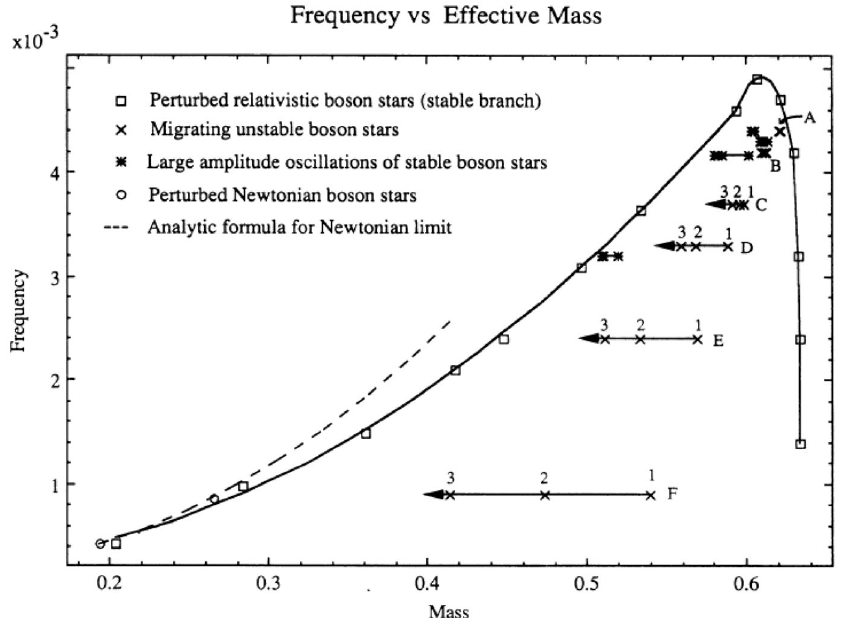
Fig. 15 Oscillation frequencies of various boson stars are plotted against their mass. Also shown are the oscillation frequencies of unstable BSs obtained from the fully nonlinear evolution of the dynamical system. Unstable BSs are observed maintaining a constant frequency as they approach a stable star con fi guration. Reproduced with permission from Seidel and Suen (1990), copyright by